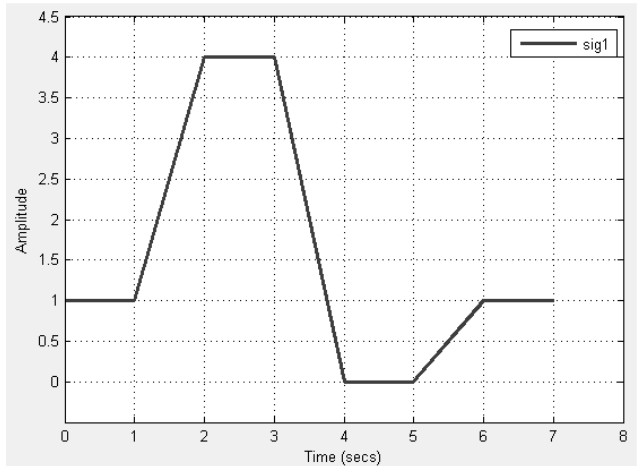
Figure 3. Signal under study.